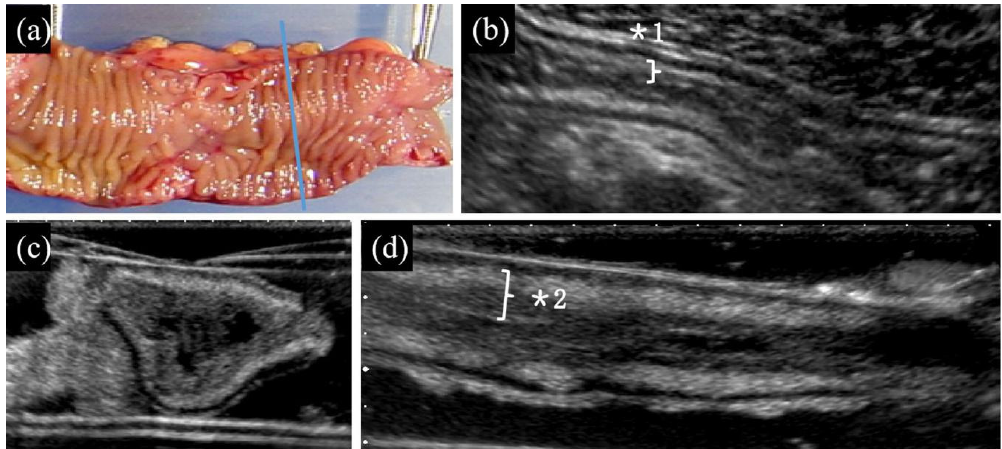
Figure 1. Macroscopically intact terminal ileum. ( a ) Macroscopic observation of locations in the resected bowel segment from open view (the blue line shows the scanning line of the transverse view). The thin and shallow annular folds are distributed regularly. Macroscopically, the segment is intact. No mucosal defects such as ulcers and erosion are seen. “Intact” indicates the macroscopically normal part of the surgical specimen between stenosis or a fistula, which was the reason for surgery. ( b ) Longitudinal view of TAUS. The wall stratification is clearly demonstrable in the submucosal and mucosal layers. The mucosal and submucosal layers show slight homogeneous thickening (*1). The mucous surface is regular in appearance. There is slight hypertrophy of adipose tissues around the intestinal wall, but the extent is limited (no more than half of the circumference of the intestine) and has not yet reached the degree of “fat wrapping”. Fistulae are not detected. Transverse ( c ) and longitudinal ( d ) views of the intestinal section by WIUS (closed view). The wall stratification of submucosal and mucosal layers is clearly visible. The mucosal and submucosal layers show mild homogeneous thickening (*2). The mucous surface is regular. Mild hypertrophy of the adipose tissue of the mesentery is present in the transverse view ( c ). The longitudinal view ( d ) shows that the width of the intestine is uniform, and there is liquid echogenicity in the intestinal cavity. No fistula signs are detected. For this lesion, trans-abdominal ultrasound (TAUS) and WIUS were consistent in determining the US parameters: (1) distinct presence of submucosal and mucosal layers; (2) thickening of the submucosal layer; (3) regularity of the mucous surface; (4) absence of increased fat wrapping; and (5) absence of fistula